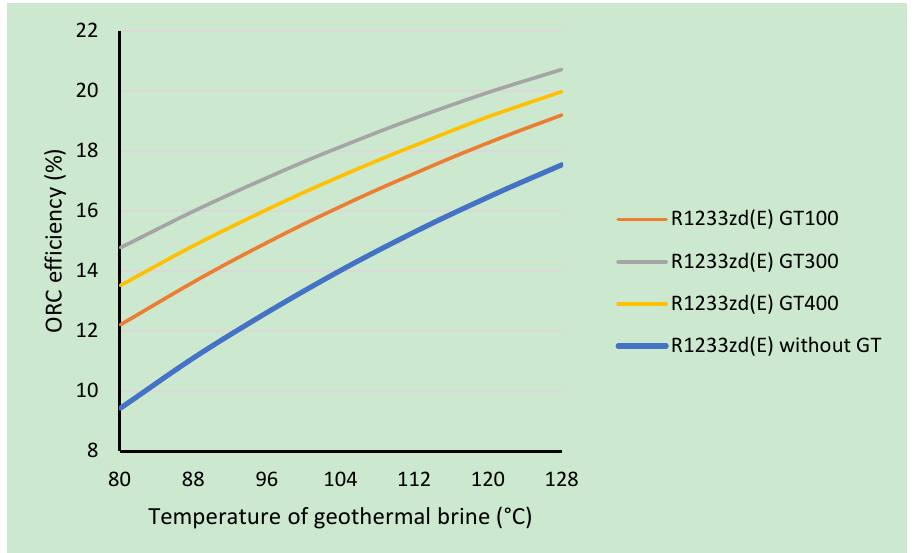
Figure 9. The efficiency of the ORC section in the modified system (assisted by gas turbine) as a function of the geothermal brine temperature with R1233zd(E) as a working fluid for different gas turbine types.